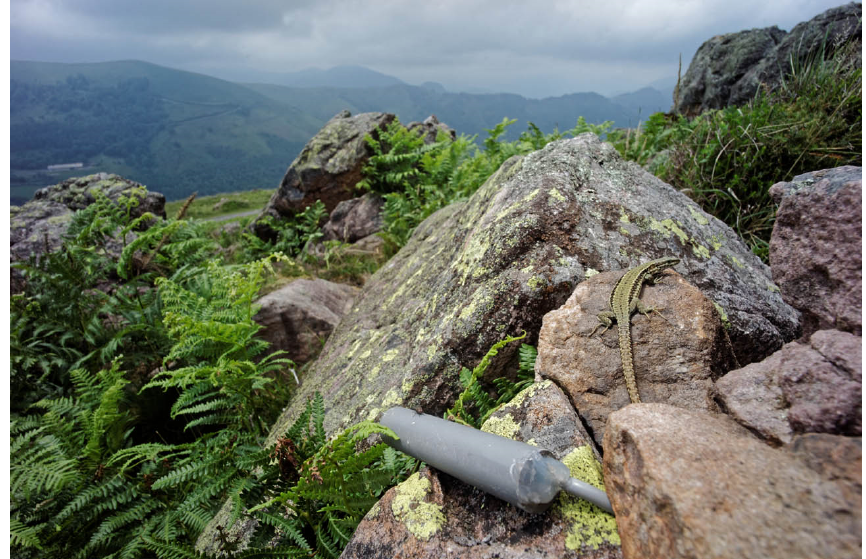
Figure 1. A PVC biomimetic logger at an exposure site, a Podarcis liolepis female basking nearby. The biomimetic model was placed on a sunbathing area. It is connected to the data-logger which is hidden under the rocks. Photographic credit: Matthieu